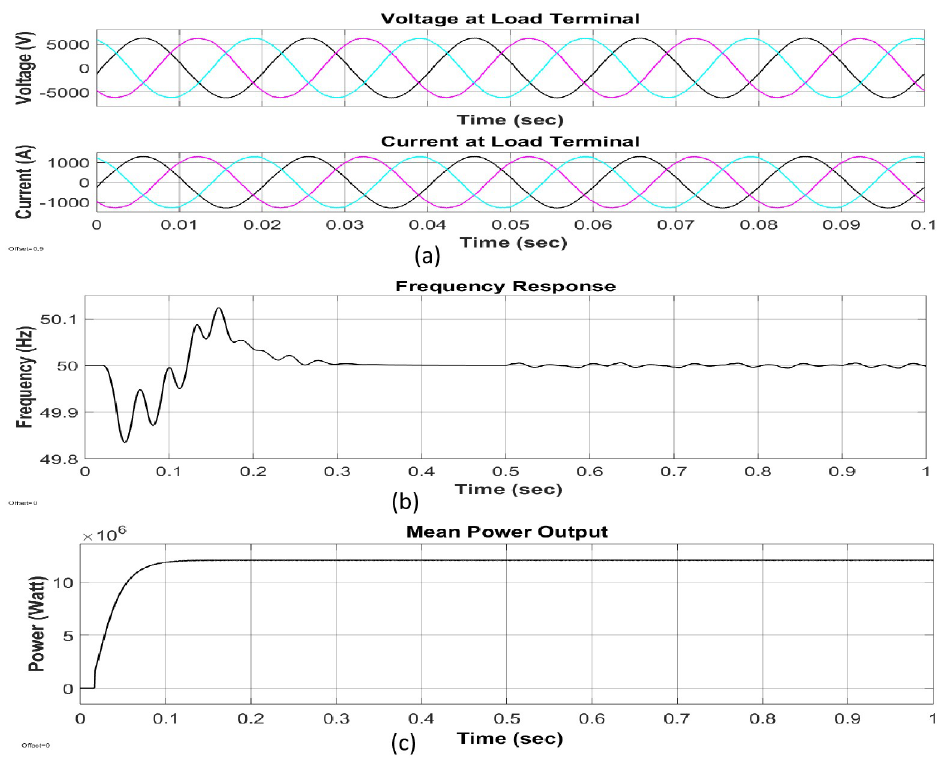
Fig 10. Output of our proposed hydroturbine: (a)three-phase parameter of voltage and current, (b)frequency response of the power output, (c) Waveform of mean output power.